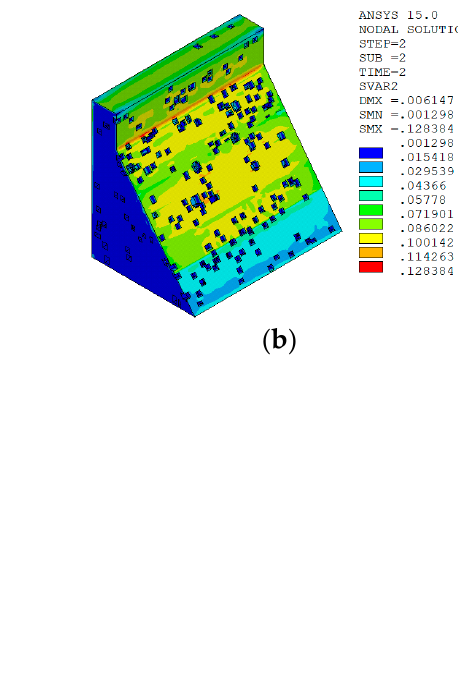
Figure 19. The temperature damage distribution in the three principal strain directions on the section z = 21 m is calculated by the macro-meso model under the temperature rise condition, ( a ) The temperature damage distribution in the first principal strain direction, ( b ) The temperature damage distribution in the second principal strain direction, ( c ) The temperature damage distribution in the third principal strain direction.